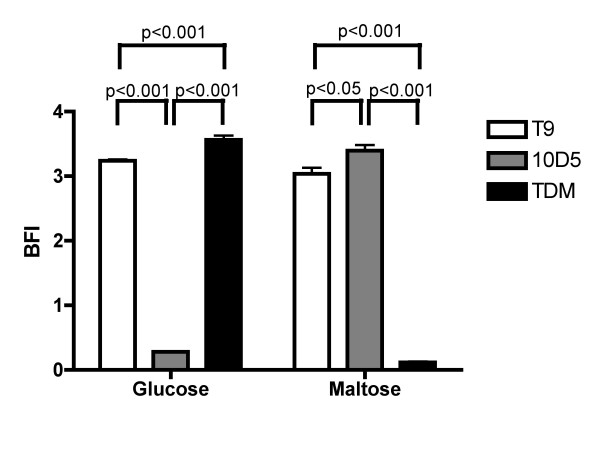
Biofilm formation of the wild-type and the two mutants in glucose (a) or maltose-containing medium (b). Biofilm formation by the wild-type was similar in medium containing glucose or maltose. The biofilm-negative transposon mutant E. faecalis produced significantly less biofilm in medium containing 1% glucose but equal amounts to the wild-type when grown in 1% maltose. The deletion mutant produced significantly more biofilm than the wild-type strain in medium containing glucose but significantly less biofilm than the wild-type or the transposon mutant E. faecalis when grown in medium containing 1% maltose.